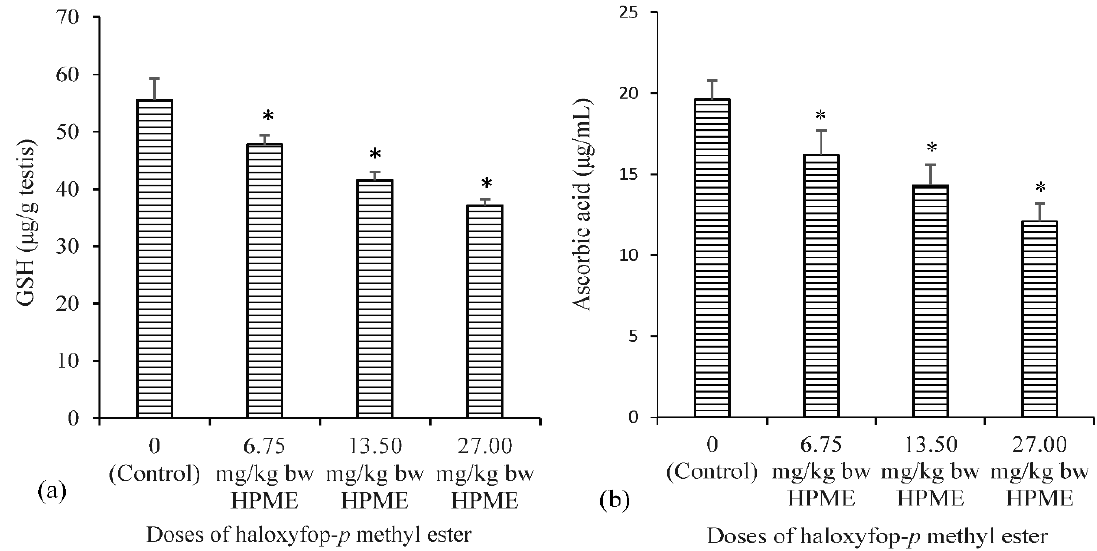
Figure 3. The influence of haloxyfop- p -methyl ester on the levels of non-enzymatic antioxidants in rat testes: ( a ) reduced glutathione; and ( b ) ascorbic acid (AA); data represent the mean of six replicates ± standard deviation. * Significance of difference at p < 0.05 (Duncan’s multiple comparison of control and HPME-treated rats).